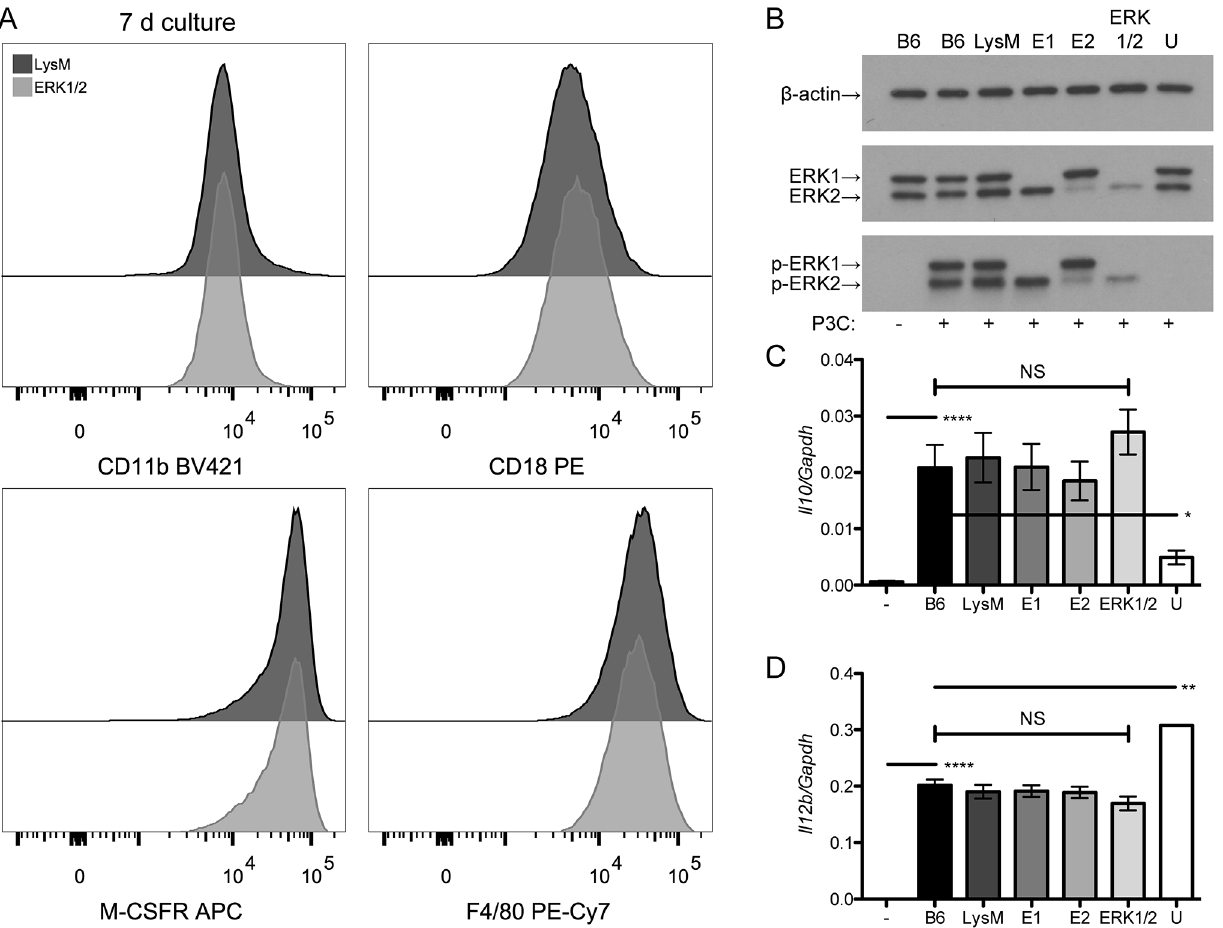
Fig 4. Macrophage marker expression and responses to TLR2 stimulation are intact in ERK1/2 macrophages. (A) Bone marrow-derived macrophages grown in LADMAC medium for 7 d were rested overnight in D10F, and then stained for CD11b, CD18, M-CSF receptor and F4/80, and analyzed by flow cytometry. Data are representative of two independent experiments. (B) Bone marrow-derived macrophages from LADMAC-stimulated cultures were rested overnight in D10F, pre-treated for 30 min with U0126 or DMSO vehicle (all others), and then treated with or without 30 nM Pam 3 CSK 4 for 15 min, lysed, and analyzed for ERK phosphorylation by Western blotting. Densitometric values (in arbitrary units) for LysM, E1 and ERK1/2, respectively, were 33.12, 30.29 and 36.6 for β -actin; 35.2, 26.5 and 2.94 for ERK2; and 28.88, 34.69 and 6.36 for p-ERK2. Results are representative of two independent experiments. (C) and (D). Bone marrow-derived macrophages were pre-treated with U0126 or DMSO as in (B) and then treated with 30 nM Pam 3 CSK 4 for 2 h (C) or 4 h (D). Gene expression was measured by qRT-PCR. These time points were previously determined to demonstrate maximal expression of Il10 and Il12b , respectively [21]. Results represent two independent experiments and show means ± standard deviations. Labels: -, untreated; +, treated with